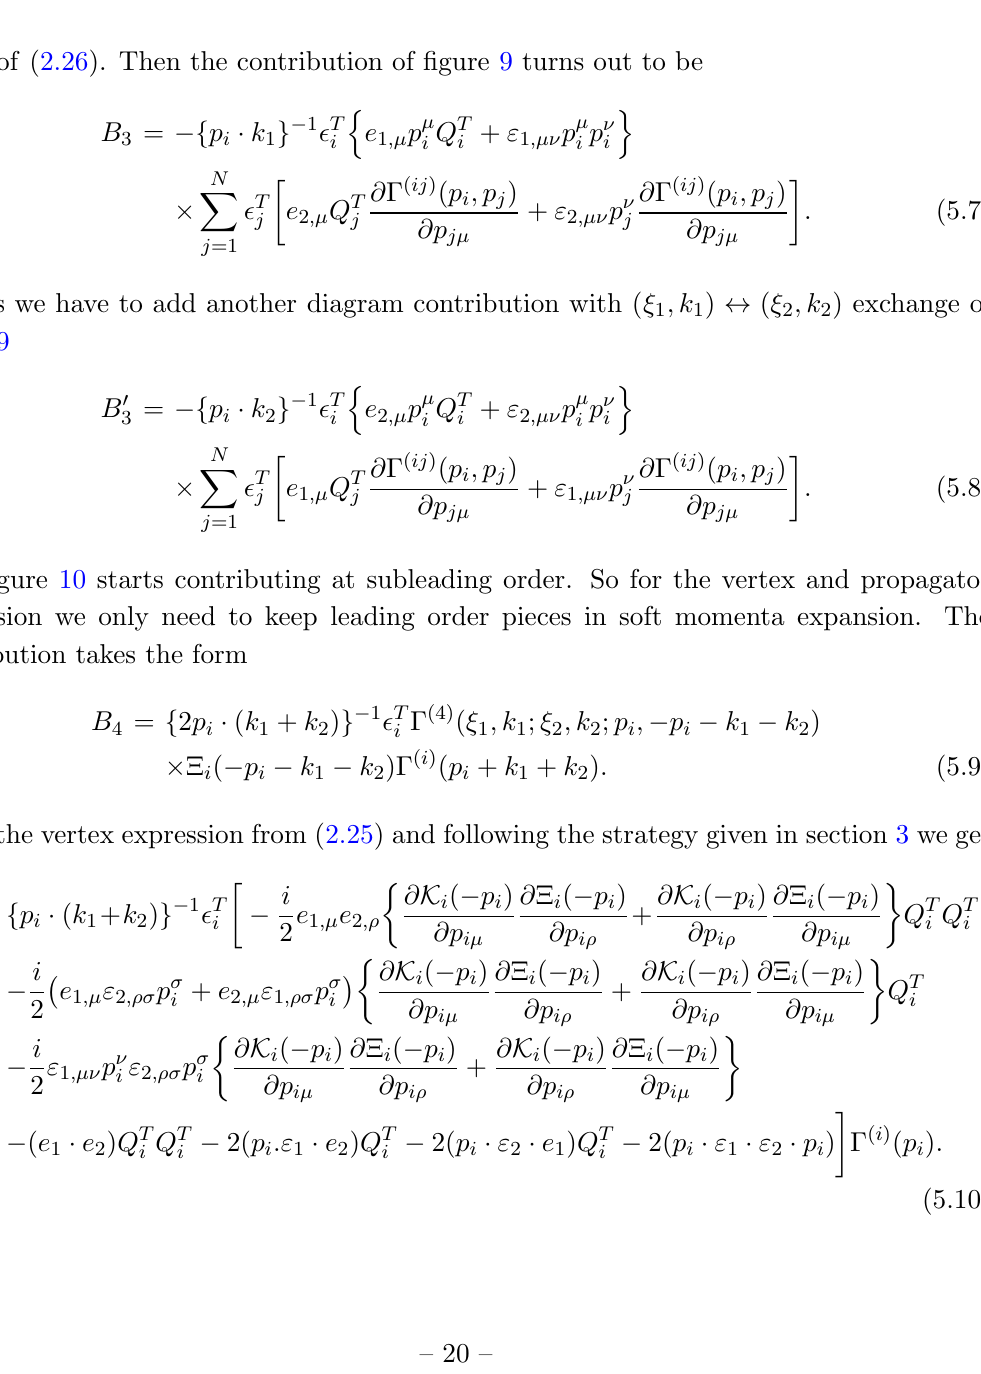
Figure 10 . Diagram containing two soft particles attached to hard leg via four point 1PI vertex starts contributing at subleading